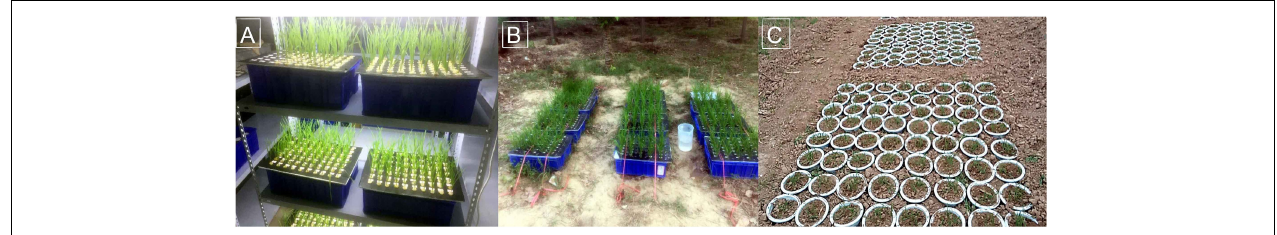
FIGURE 1 | Root experiments on 196 accessions under three growing environments. (A) Indoor hydroponic culture (IHC); (B) outdoor hydroponic culture (OHC); and (C) outdoor pot culture